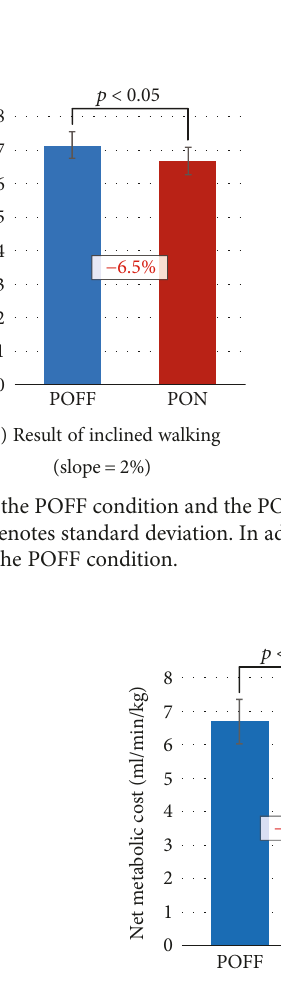
Figure 8: Comparison of two-day average value of metabolic cost between the POFF condition and the PON condition for entire 30-minute walking. On each bar chart, the error bar denotes standard deviation. In addition, the number expressed in percentage represents the di ff erence of the PON condition compared with the POFF